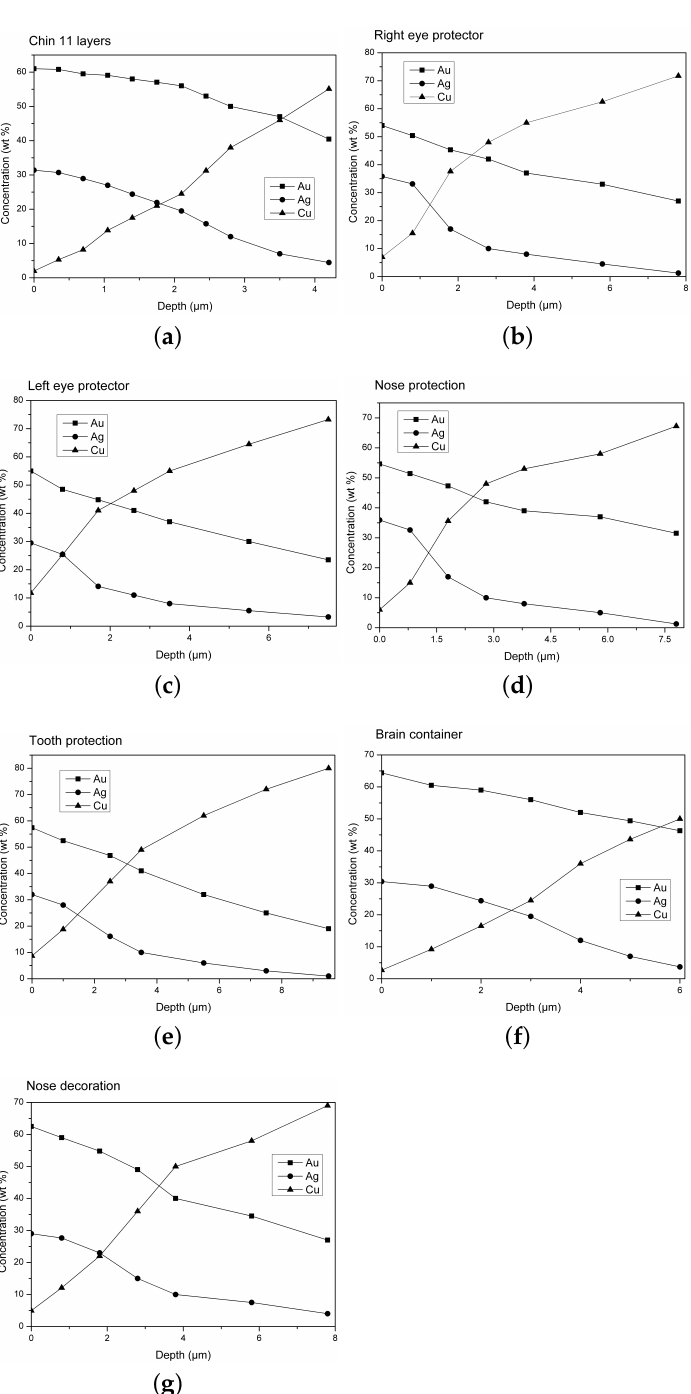
Figure 6. Estimated trends of gold, copper and silver concentrations vs. depth profiles for each Tumbaga sample examined. ( a ) Chin 11 layers; ( b ) Right eye protector; ( c ) Left eye protector; ( d ) Nose protector; ( e ) Tooth protector; ( f ) Brain container; ( g ) Nose